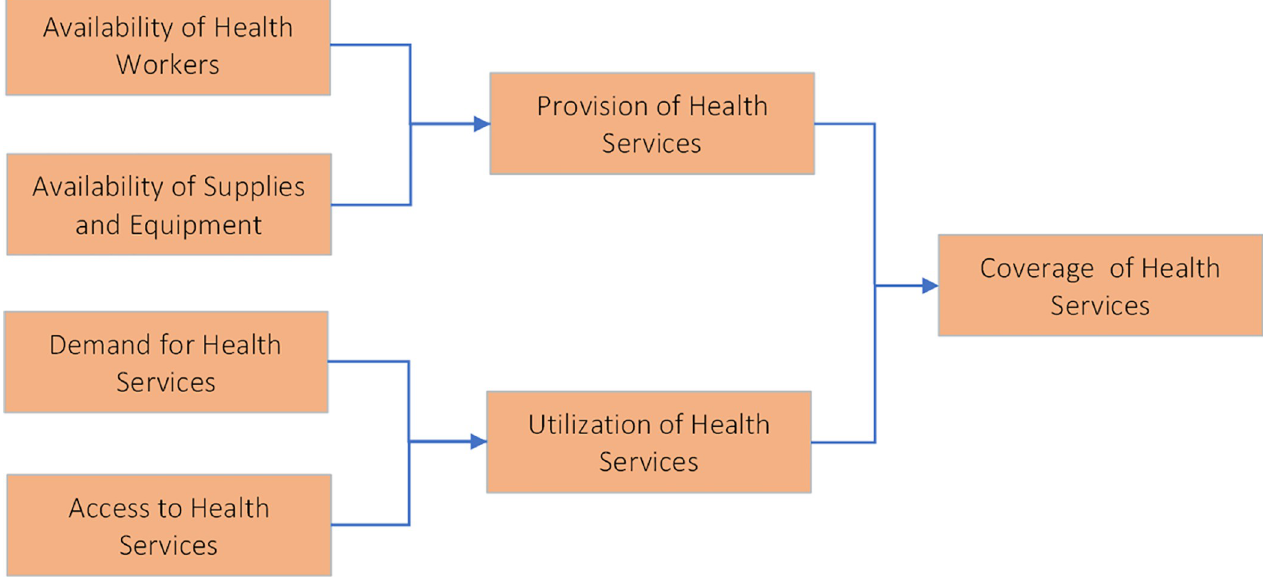
Fig 1. Framework for the effects of health system components on coverage of health services �� . �� Derived from Roberton T. et al. 2020 [15]. Early estimates of the indirect effects of the COVID-19 pandemic on maternal and child mortality in low-income and middle-income countries: A modelling study. Lancet Glob Health 2020; 8: e901–08. (Permission obtained).